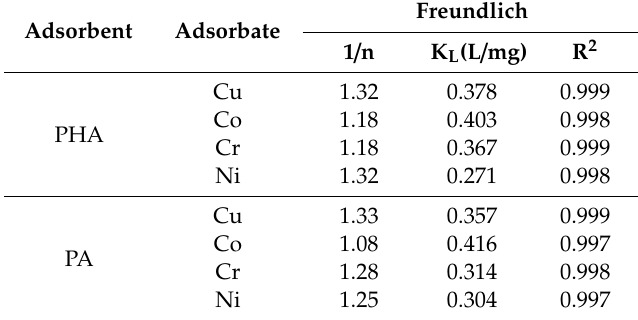
Figure 13. Freundlich isotherm curves obtained by linear fitting on the adsorption of metal ions by the jute cellulose-based polymer ligands: ( a ) represent PHA and ( b ) represent PA ligand; experimental variables: 0.5 g of ligands (PHA or PA), 15 mL distilled water, 5 mL pH 6 buffer solution, 5 mL of 0.2 M synthetic metals ions solution and stirred for 2 h. Table 4. Freundlich isotherm parameters for polymer adsorbent, PHA/PA.